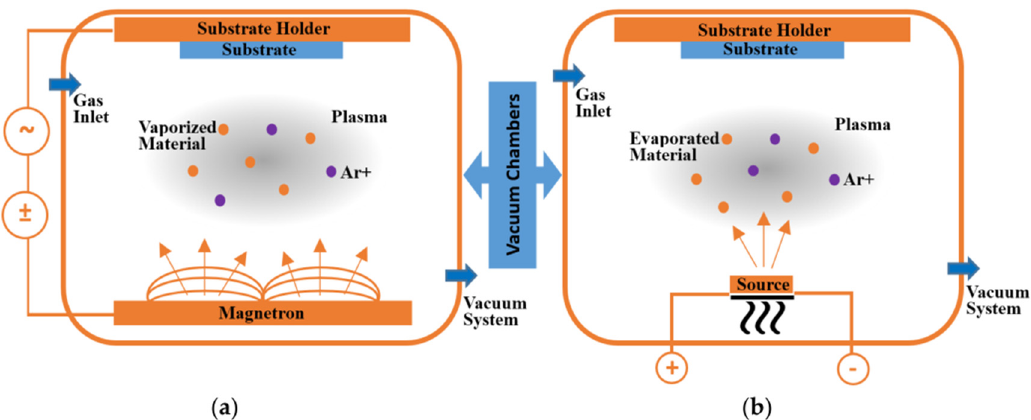
Figure 3. Schematic drawing of two conventional physical vapor deposition (PVD) processes: ( a ) sputtering and ( b ) evaporating using ionized argon (Ar+) gas [29].